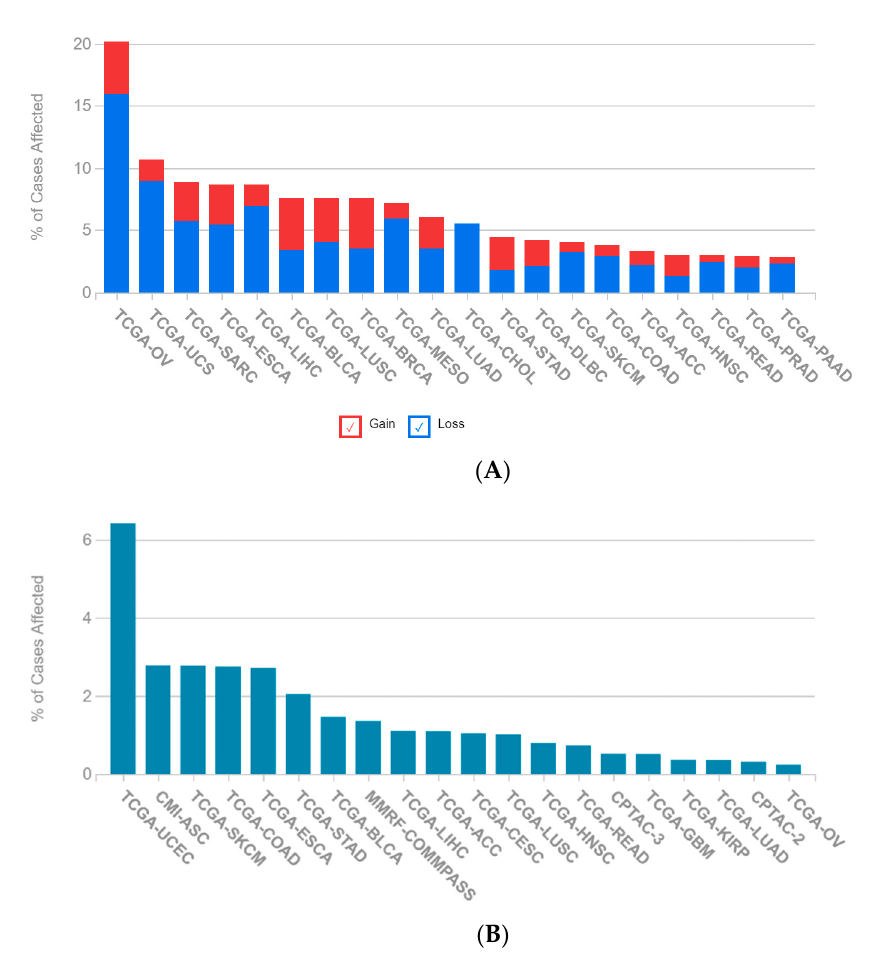
Figure A6 . CNV and mutation distribution of SLC39A8 in different cancer types. ( A ) CNV distribution. ( B ) Mutation distribution.